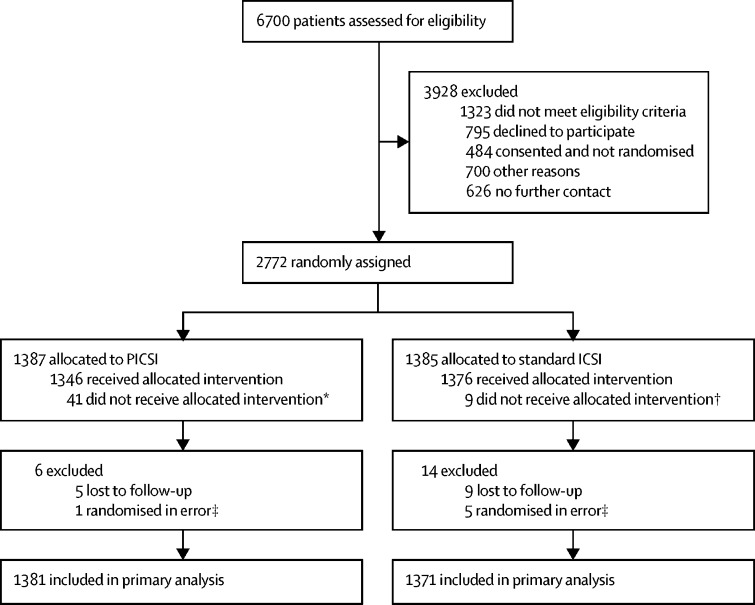
Trial profilePICSI=physiological intracytoplasmic sperm injection. ICSI=intracytoplasmic sperm injection. IVF=in-vitro fertilisation. *Three received IVF, two received IVF–ICSI split cycle, and 36 received ICSI. †Five received IVF, three received IVF–ICSI split cycle, and one received PICSI. ‡These individuals were found to not meet eligibility criteria after randomisation.